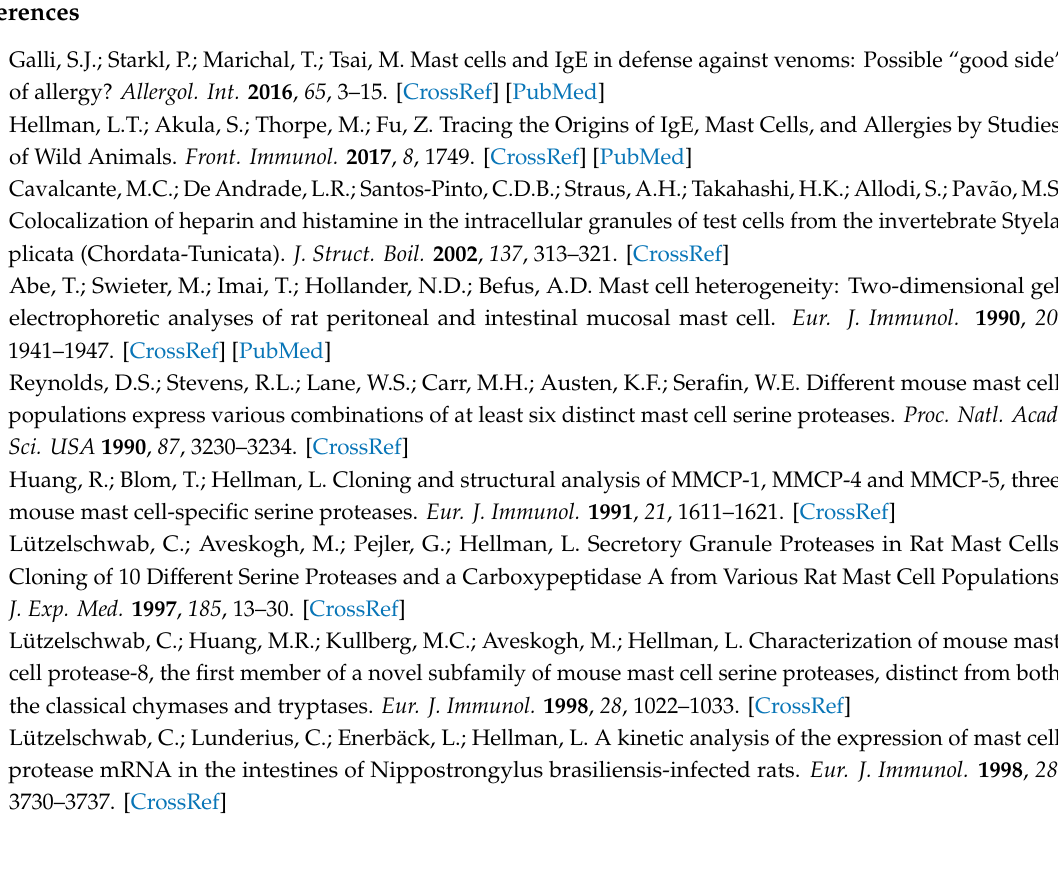
Table S1: Granule proteases, Table S2: Protease Inhibitors, Table S3: Ig Receptors and related, Table S4: Cytokine and Chemokine Receptors, Table S5: MAS GPR Receptors, Table S6: Endothelin, ATP, Histamine and Adreneric Receptors, Table S7: Other Receptors, Table S8: Cluster of Di ff erentiation (CDs), Table S9: TLR & Olfactory Receptors, Table S10: Adhesion molecules, Table S11: Proteoglycan, histamine and lipid mediator synthesis, Table S12: Cytokines and Chemokines, Table S13: Transcription factors, Table S14: RNA binding proteins, Table S15: Cell division, Table S16: Cell signaling, Table S17: Intracellular transport, Table S18: Other various